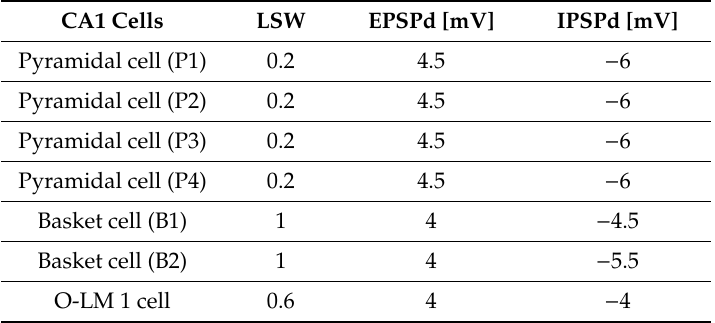
Table 1. Initial parameters microcircuit model of CA1 network.